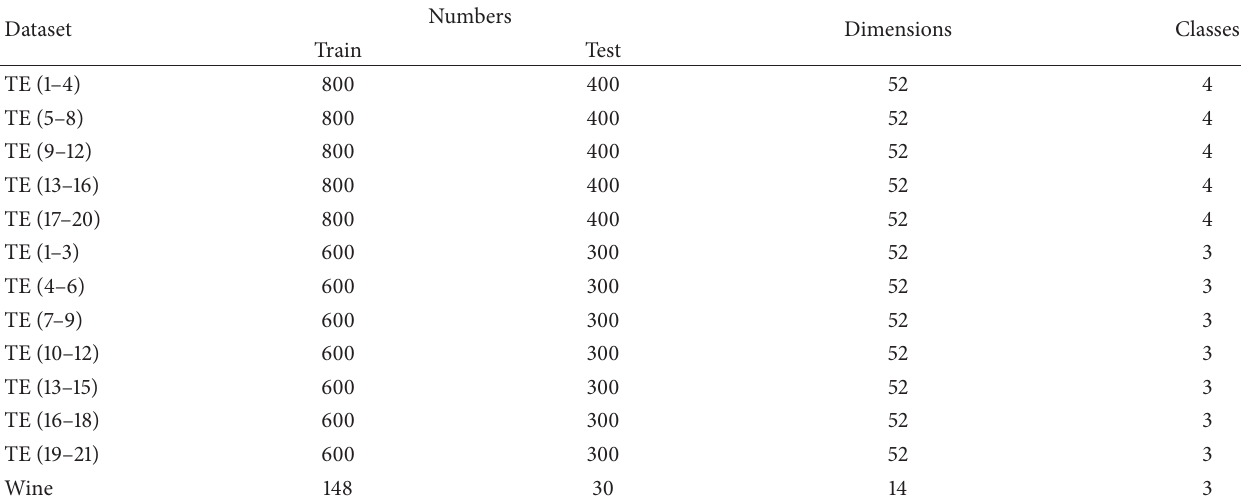
Table 1: The datasets descriptions and parameter